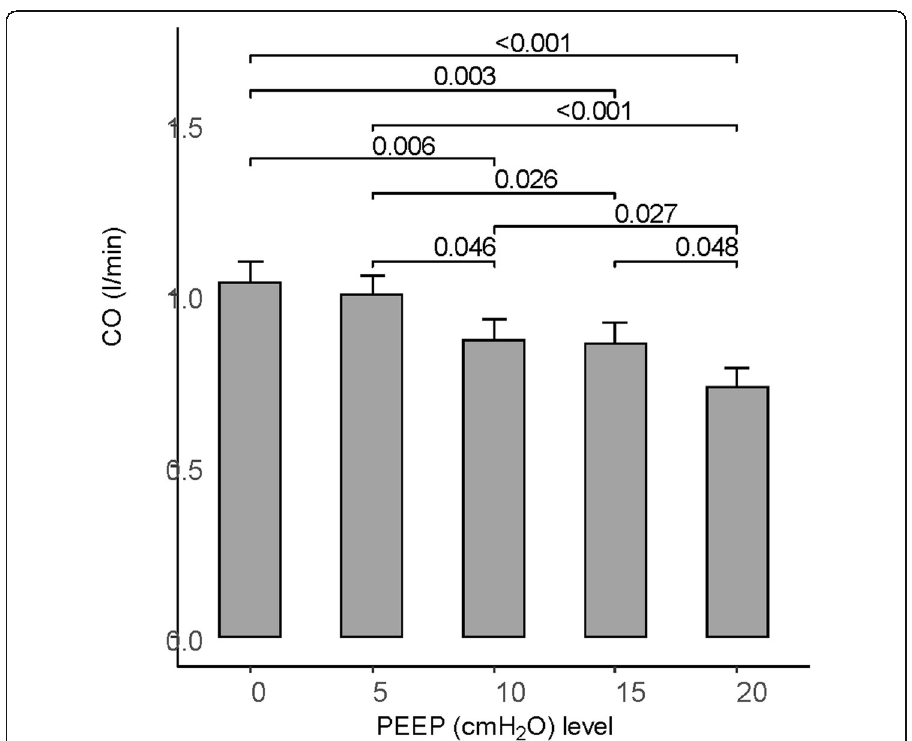
Fig. 1 Comparison of cardiac output for the different positive end-expiratory pressure (PEEP) levels during cardiopulmonary resuscitation. CO cardiac